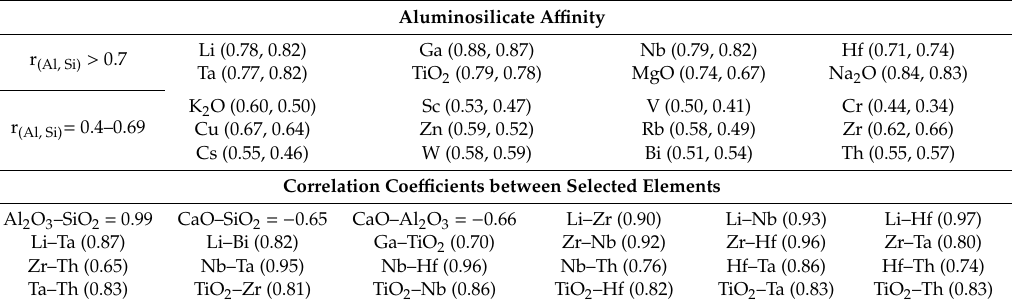
Table 5. Correlation coe ffi cients between the concentrations of trace and major elements in the Wujiawan coal and selected elements.